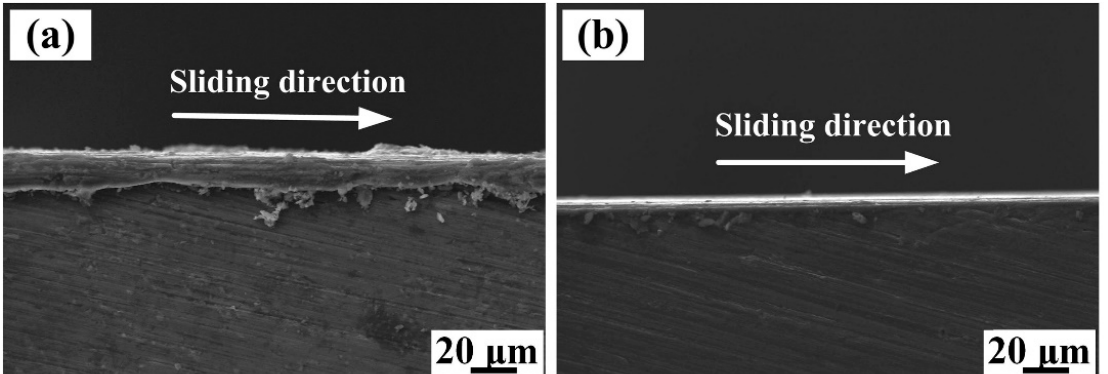
Figure 11. SEM images of longitudinal cross-section worn scar of ( a ) Al-4.7Cu-0.32Mg-0.44Si alloy and ( b ) 40 wt.% (TiC-TiB 2 )/Al-4.7Cu-0.32Mg-0.44Si composite under 5 N load and 13 μ m Al 2 O 3 abrasive size.